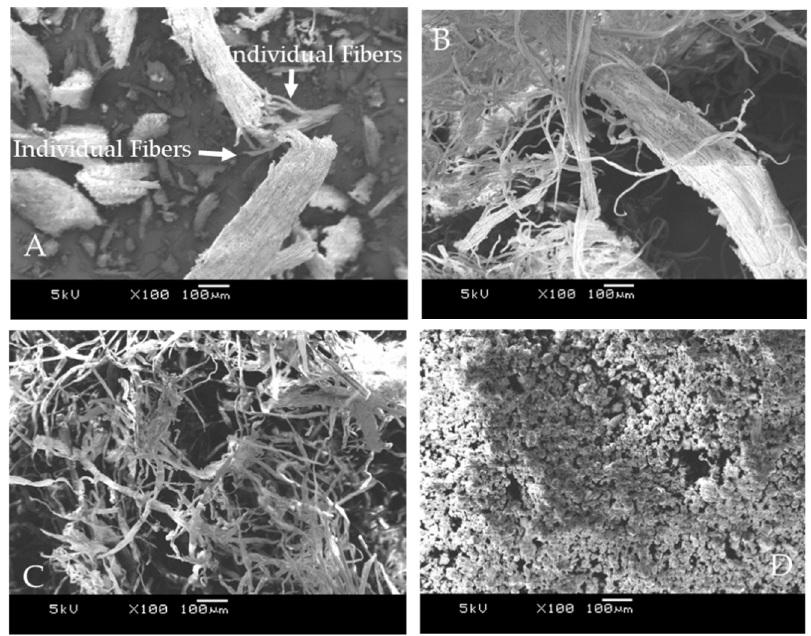
Figure 6. SEM images of ( A ) DPTM, ( B ) delignified DPTM, ( C ) cellulose and ( D ) NC.